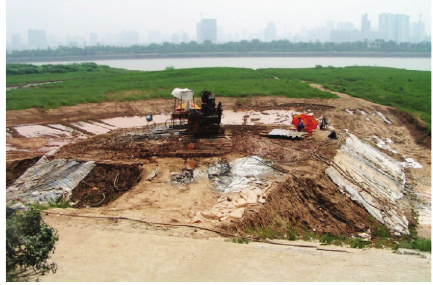
Figure 5: The platform for grouting work.